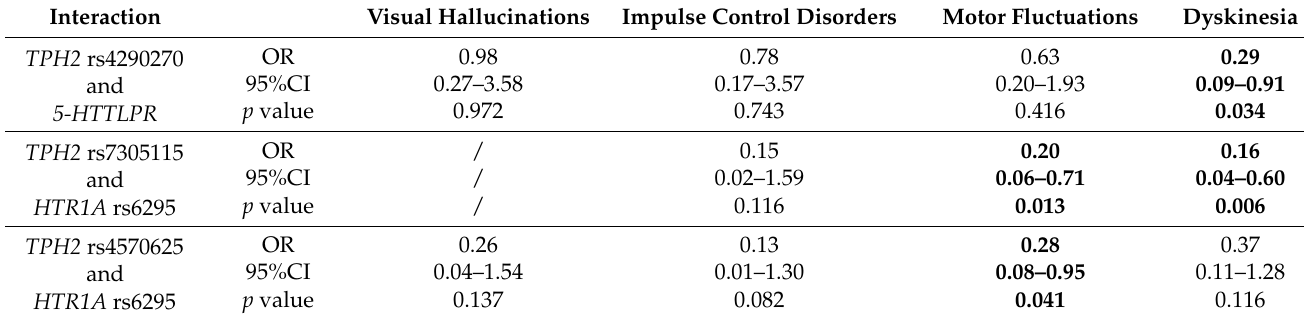
Table 4. Nominally significant associations in the gene–gene interaction